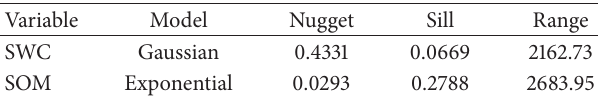
Table 1: Variograms of soil water content and soil organic